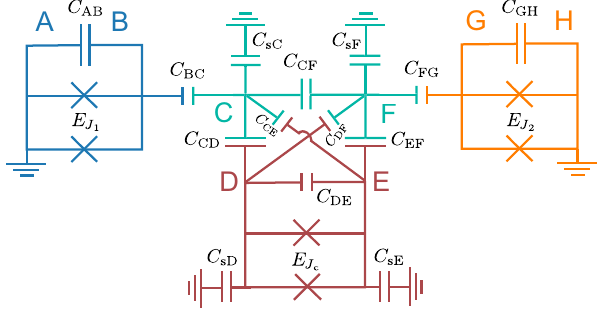
FIG. 5. The lumped-element circuit diagram of the floating- coupler scheme. The drawn sizes of the capacitors roughly indicate the relative magnitudes between the designed values of the capacitances. The crosses indicate the Josephson junctions with the Josephson energy E J